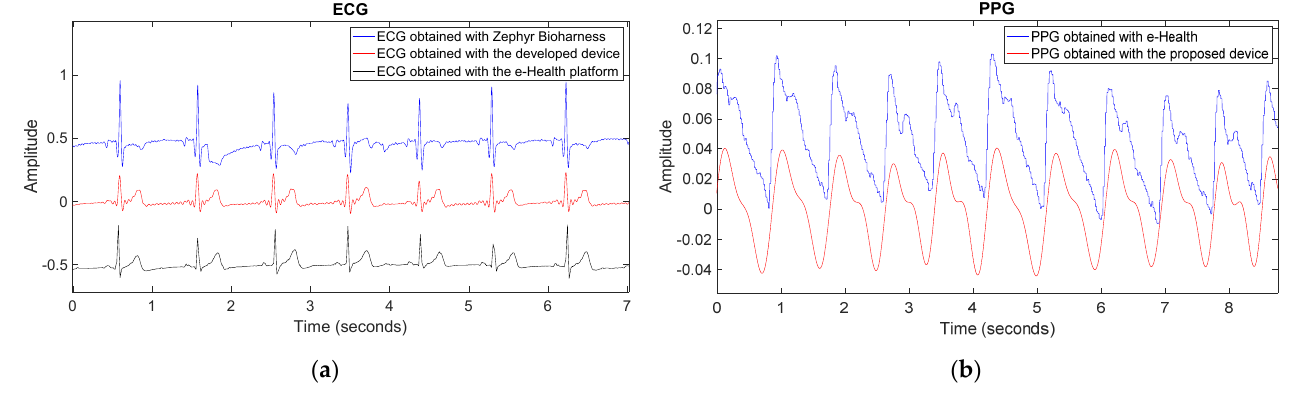
Figure 12. ( a ) ECG signal obtained with Zephyr BioHarness in blue, with ‐ Health in dark and ECG with the proposed device in red; ( b ) PPG signal obtained with the e ‐ Health pulse oximeter in blue and with the proposed device in red.